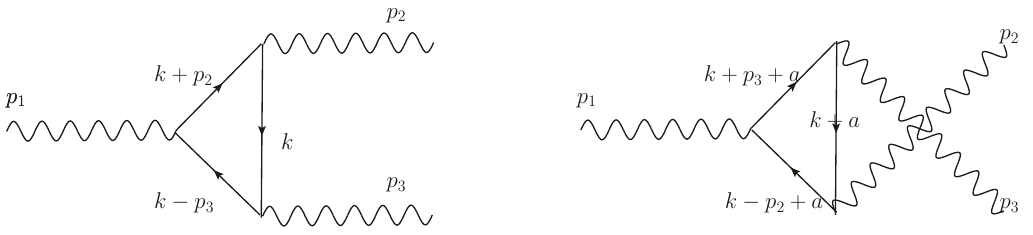
Figure 2 . Diagrams relevant for the Z 0 V V vertex function calculation. The integration variable k of one diagram can be shifted with respect to another by an arbitrary momentum a